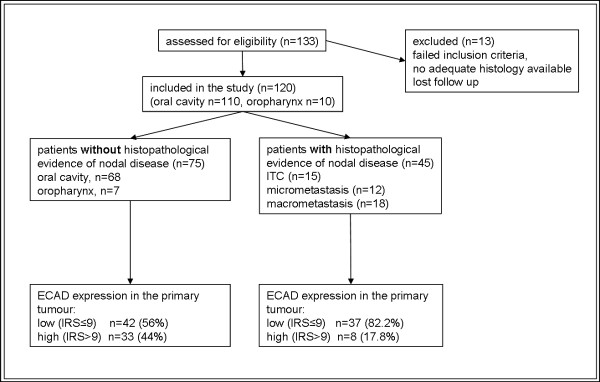
Example of a participant flow diagram. [177]